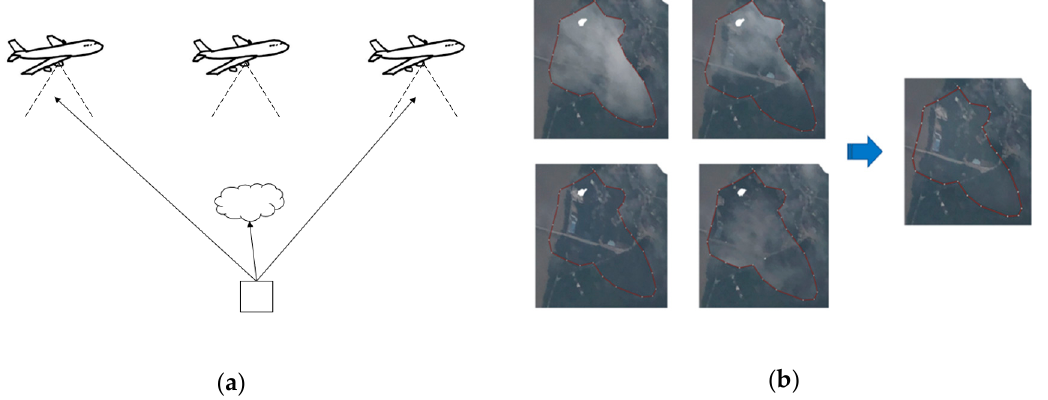
Figure 3. ( a ) A sketch map showing different viewing angles during flights, and ( b ) an example showing how multi-view images generate cloud-free images.